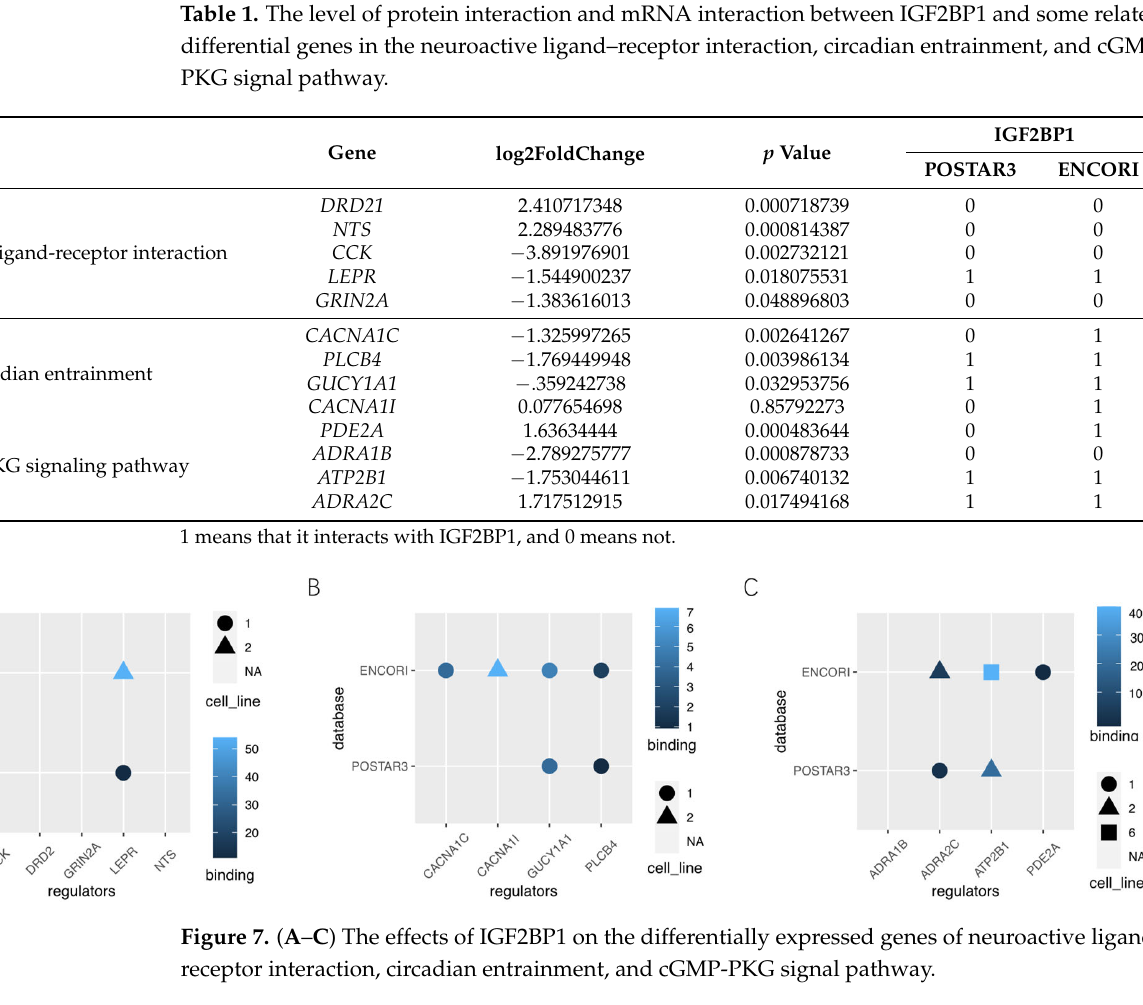
Table 2, there was no difference in the p -values. We performed western blot analysis on METTL3, FTO, ALKBH5, and YTHDC2 and found that METTL3 ( p = 0.148639; Figure 8A) was not significantly different from the control group, but FTO ( p = 0.017; Figure 8B) and ALKBH5 ( p = 0.025; Figure 8D) were up-regulated (Figure 8B), and YTHDC2 ( p = 0.049; Figure 8D) was